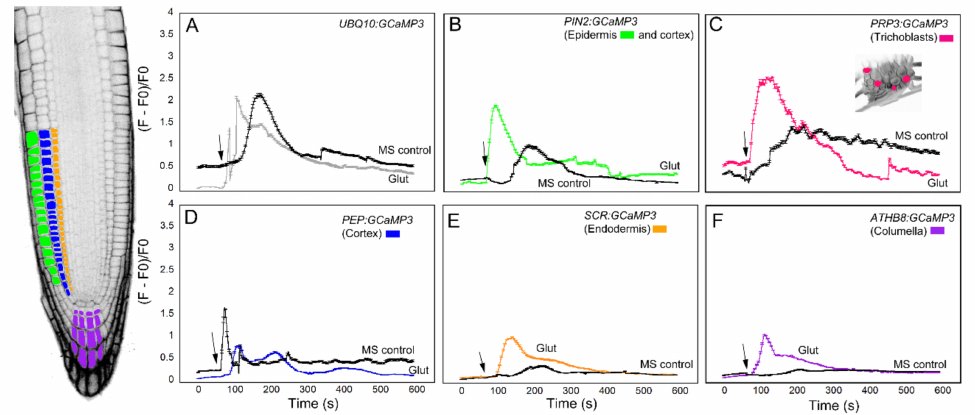
Figure 4. Time course of [Ca 2 + ] cyt changes in A. thaliana roots after 1 mM glutamate (Glu) application. The leftmost panel shows an inverted fluorescence image of the terminal 300 µ m of an A. thaliana primary root to illustrate di ff erent cell types in which GCaMP3 was expressed. Cell types are color coded with green = epidermis; blue = cortex; orange = endodermis; purple = columella; and the pink cells in the inset in panel C = trichoblast. ( A – F ) Quantification of [Ca 2 + ] cyt -dependent fluorescence of various lines expressing GCaMP3 after Glu and solvent control (0.5 × MS) application. Black arrows indicate the time of treatment. Plotted values represent the average normalized fluorescence intensity from 3–4 regions of interest (ROI) per line with standard error bars every fifth time point. Fluorescence values were normalized to the lowest fluorescence